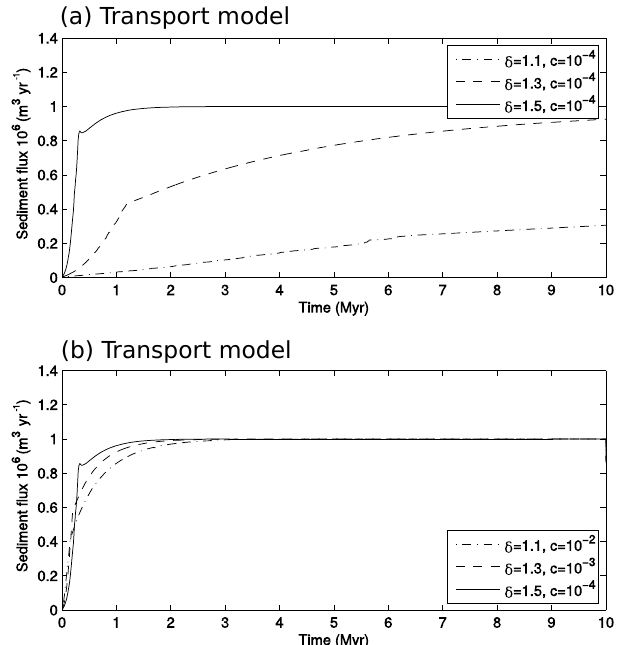
Figure 2. Sediment flux out of the model domain for the trans- port models in which (a) δ = 1 . 1, 1.3, and 1.5, κ = 10 − 2 and c = 10 − 4 (m 2 yr − 1 ) 1 − δ ; (b) δ = 1 . 1, 1.3, and 1.5, κ = 10 − 2 and c = 10 − 2 , 10 − 3 , and 10 − 4 (m 2 yr − 1 ) 1 − δ .